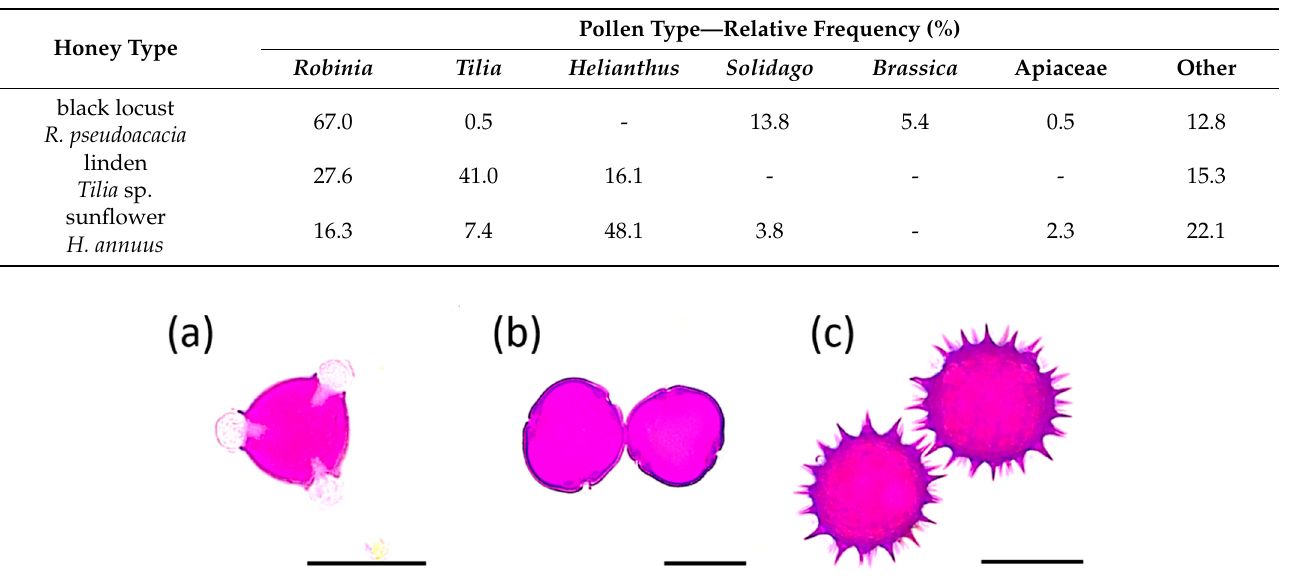
Figure 1. Analysis of botanical origin of honey samples with light microscopy. Pollen grains of: ( a ) black locust, ( b ) linden, and ( c ) sunflower. Scale bar = 25 μ m.